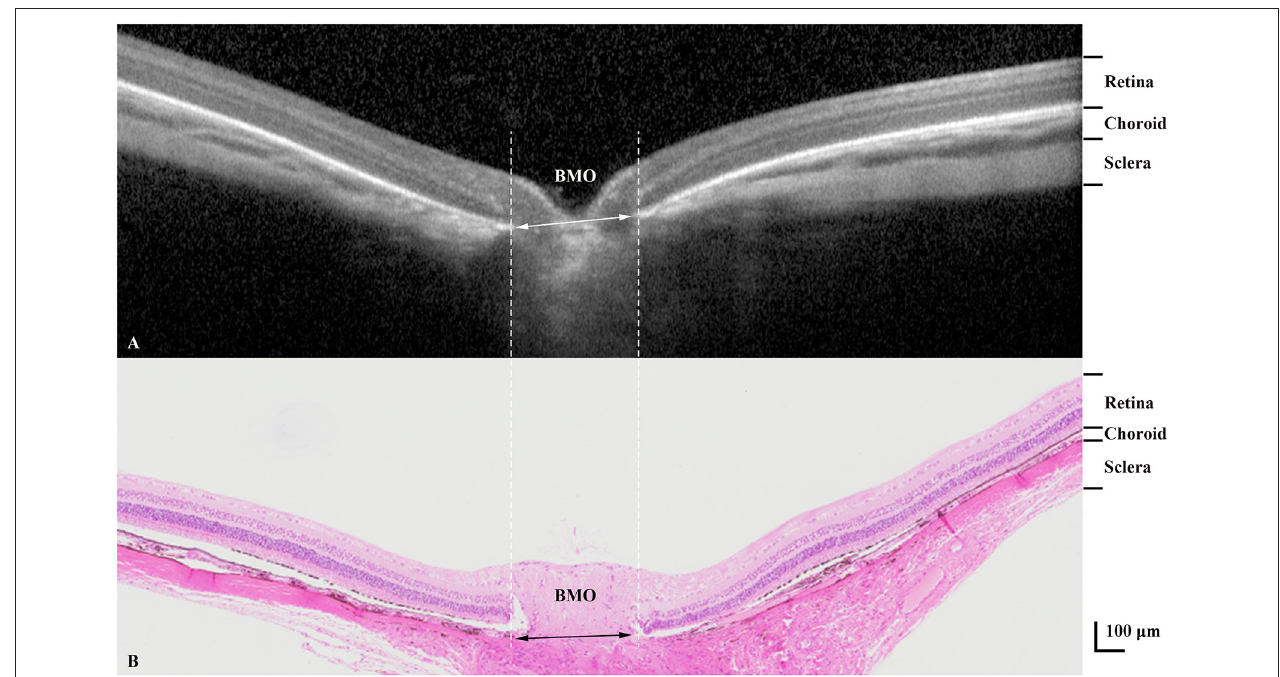
TABLE 4 | Comparison of measurements performed by OCT and histomorphometry in 10 eyes of guinea pigs. Parameters OCT Histology Difference 95% CI t P -value Pearson Mean retinal thickness ( µ